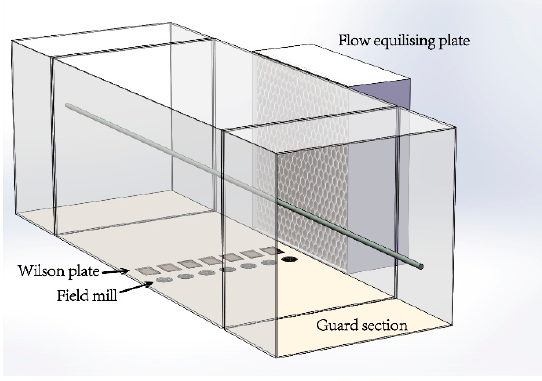
Figure 7. Schematic diagram of the experimental setting.